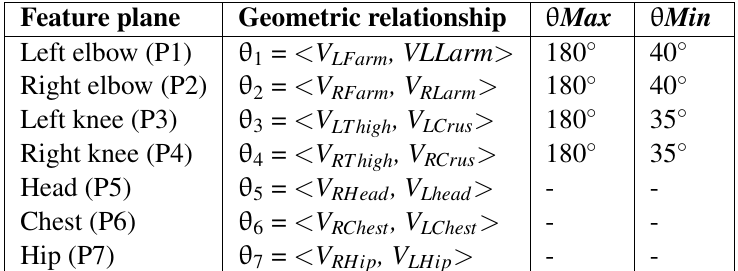
Table 2 Determining the included angle on the characteristic